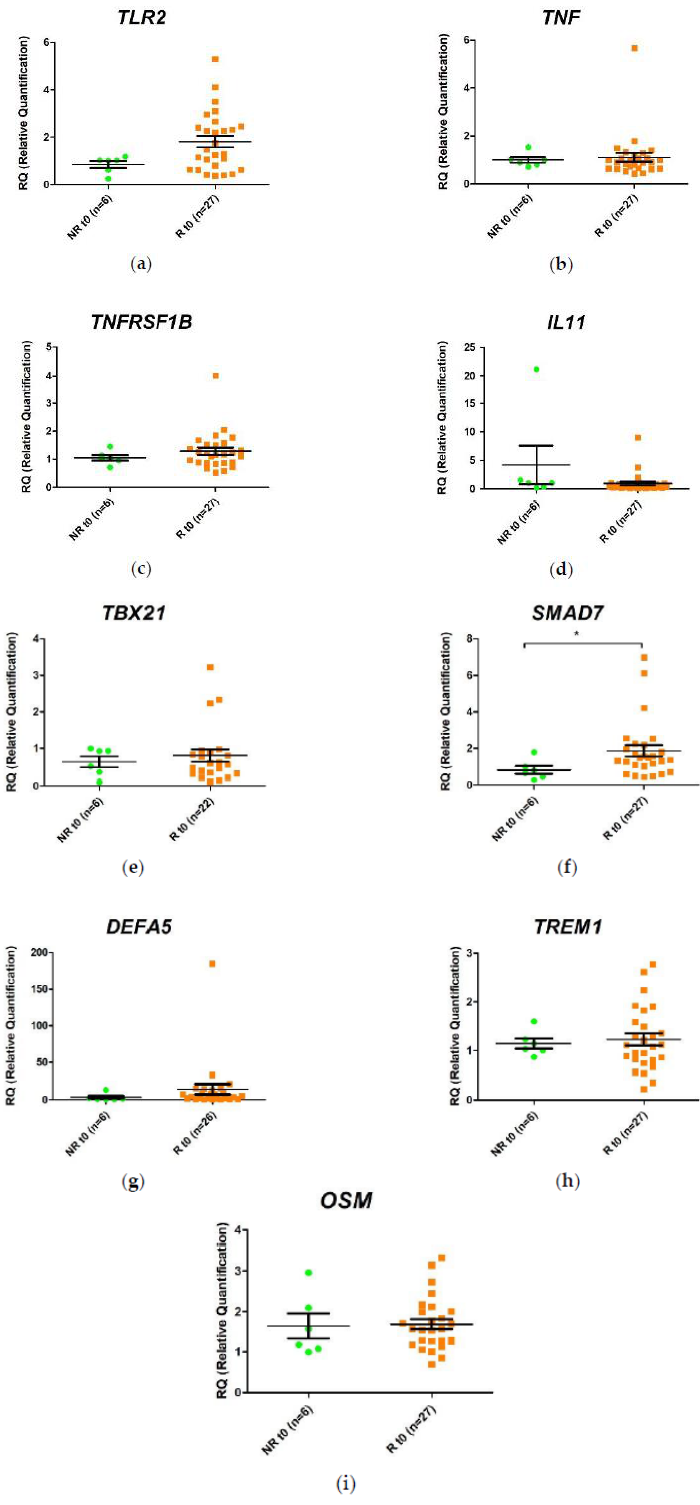
Figure 2. Relative expression levels of the ( a ) TLR2 , ( b ) TNF , ( c ) TNFRSF1B , ( d ) IL11 , ( e ) TBX21 , ( f ) SMAD7 , ( g ) DEFA5 , ( h ) TREM1 , and ( i ) OSM genes in responders (R) and non-responders (NR) at time 0. Expression values were normalized to HPRT1 and GAPDH genes. Values are expressed as mean (horizontal line), standard error of the mean (SEM). n , sample size. * p value < 0.05 vs. control (unpaired t -test).